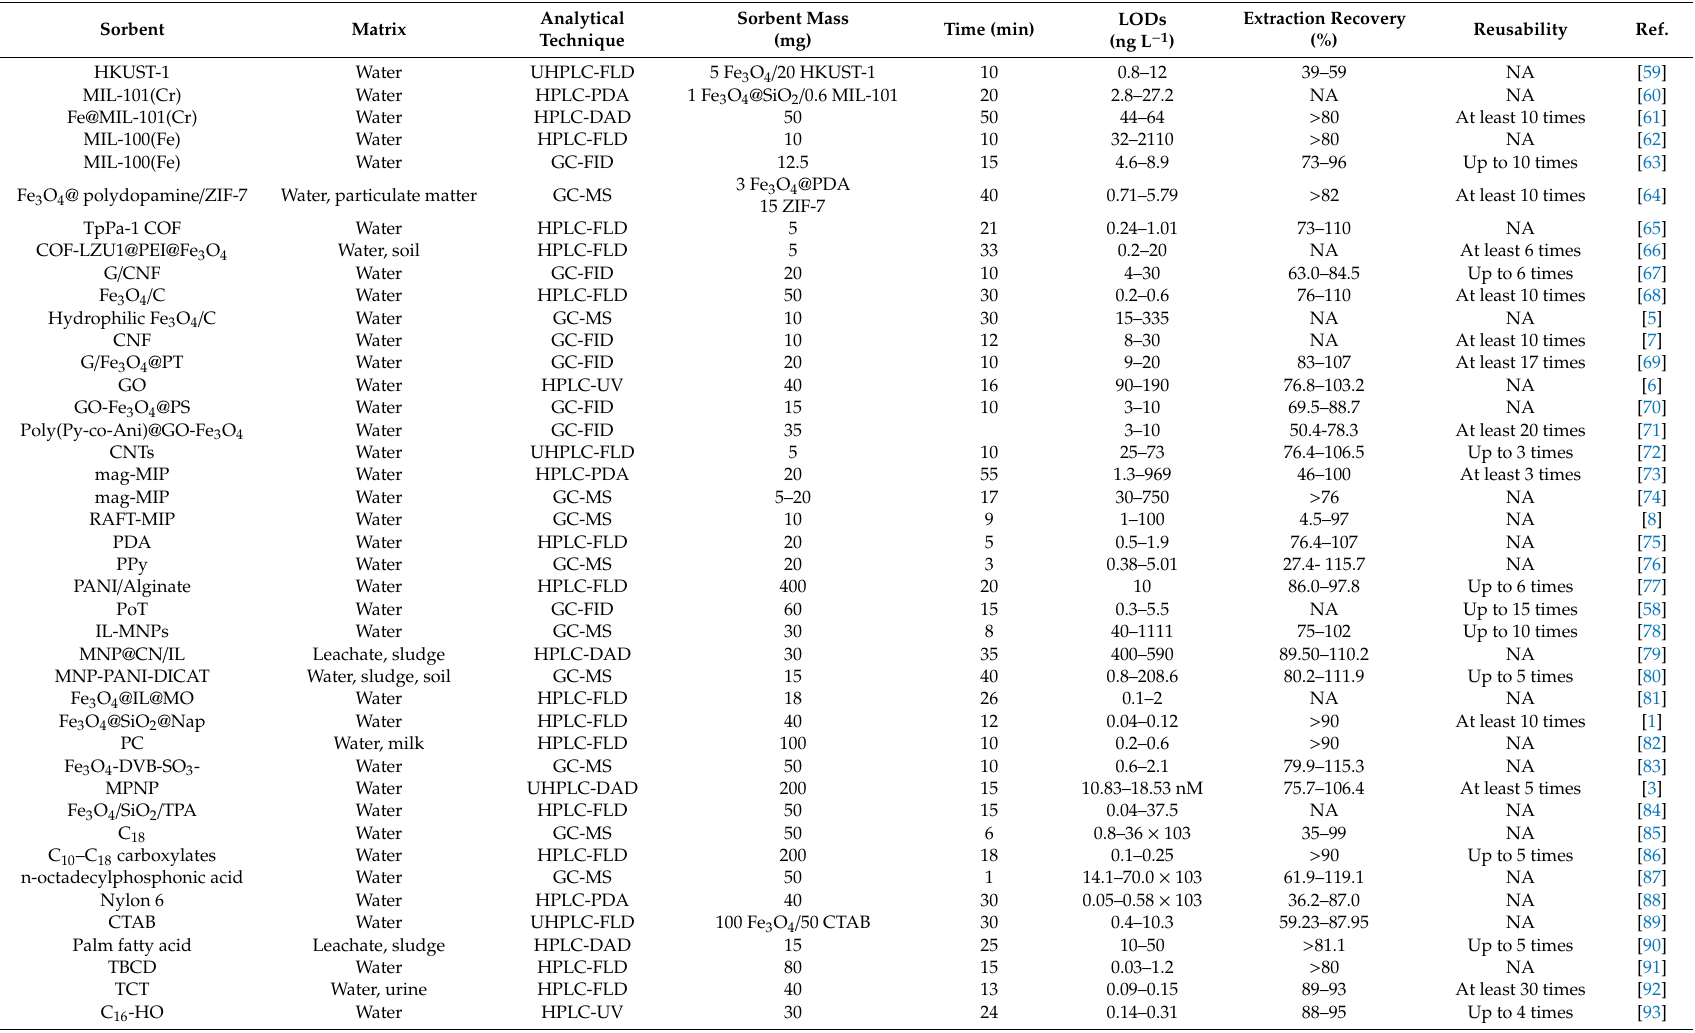
Table 1. Application of di ff erent sorbents for the magnetic solid-phase extraction (MSPE) of PAHs from environmental